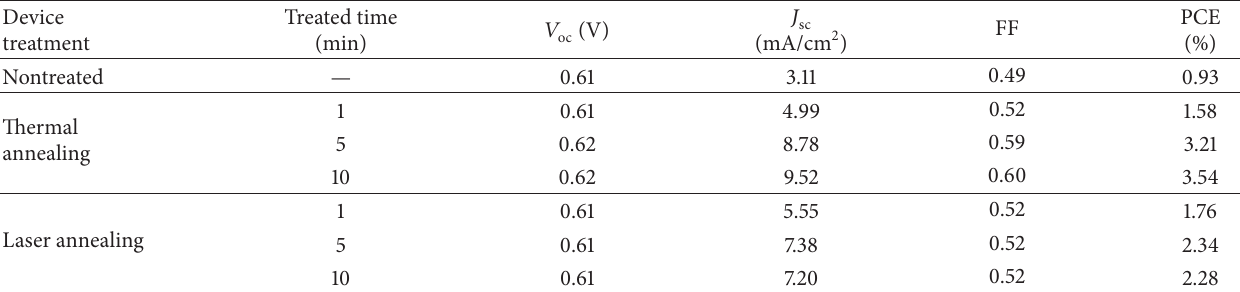
Table 1: The 𝑉 , 𝐽 , FF, and PCE of the devices without annealing treatment, with thermal annealing process, and with laser annealing oc sc process under different duration.